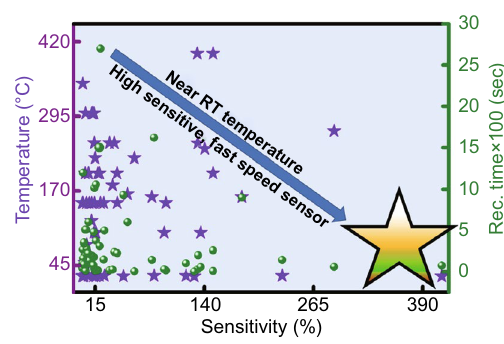
Fig. 2 Schematic representation of strategies adopted to develop a high-performance NO 2 gas sensor based on MoS 2 flakes